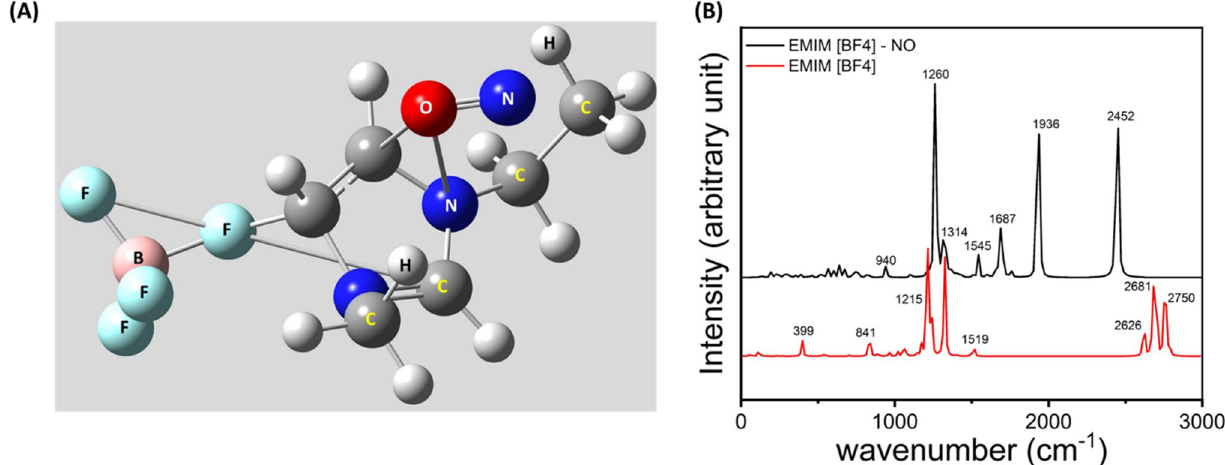
Figure 2. ( A ) Optimized structure of EMIM[BF 4 ]-NO depicts strong interaction of NO with EMIM[BF 4 ] moiety. ( B ) FTIR comparison of EMIM[BF 4 ] and EMIM[BF 4 ]-NO showing substantial peak shift.